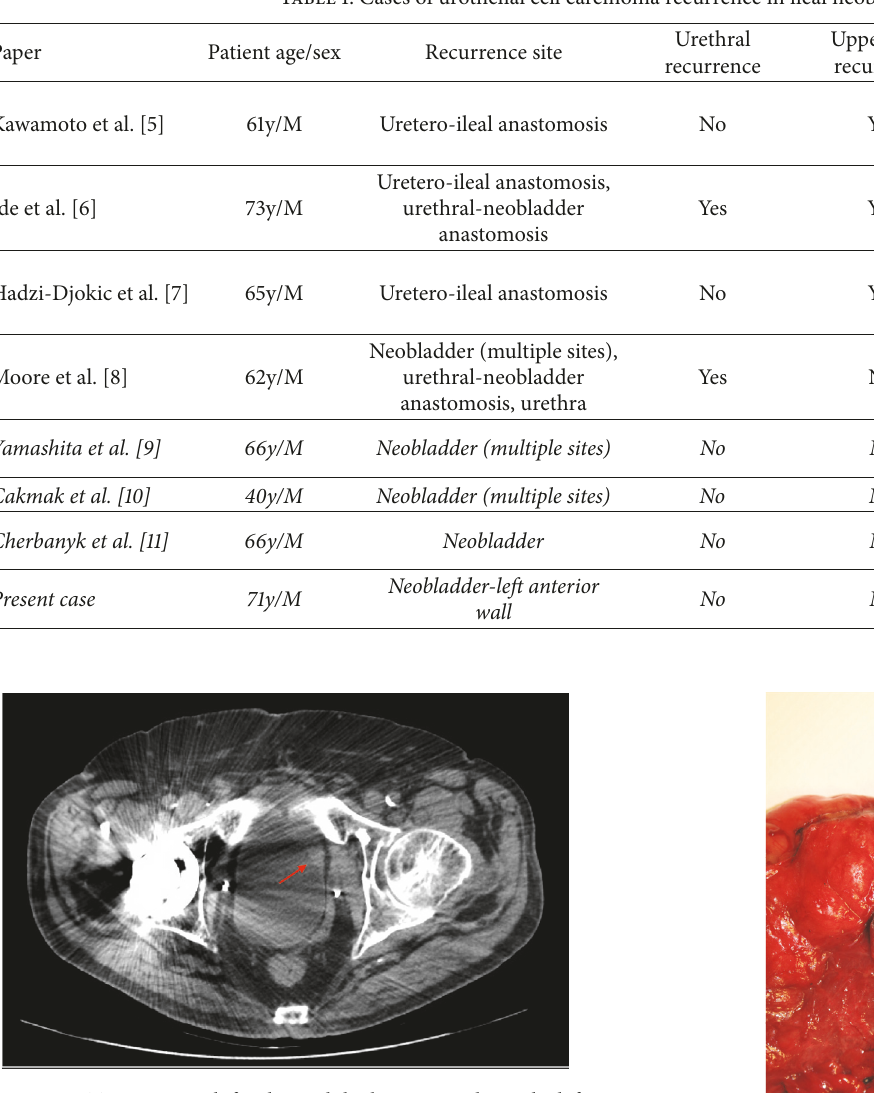
Figure 1: CT imaging with focal mural thickening involving the left anteroinferior neobladder.